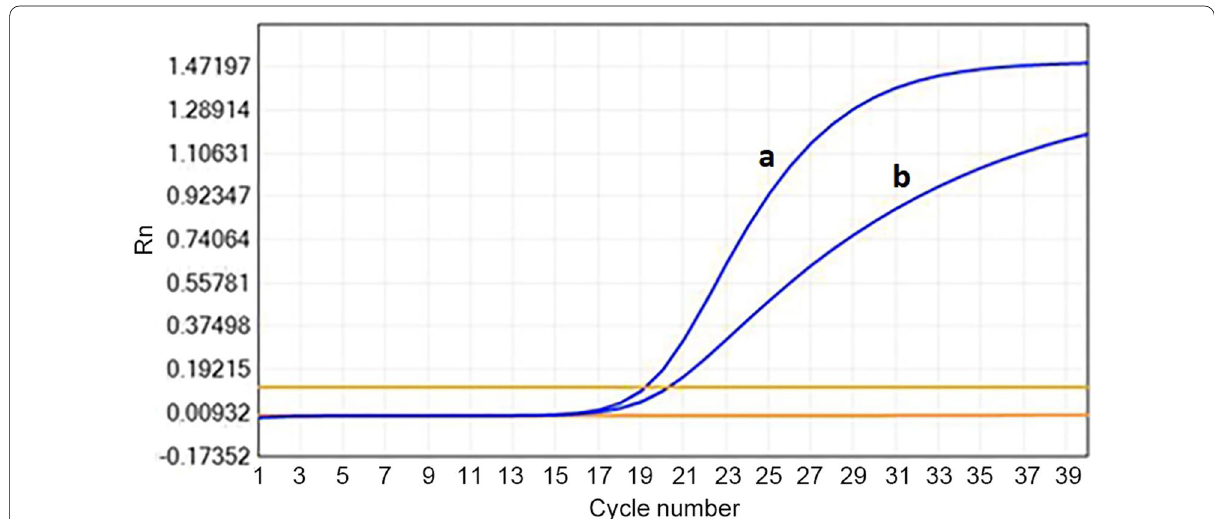
Fig. 1 Better PCR amplification effect was obtained after enzyme-lysed C.albicans sample treated with high temperature metal bath. The amplification curve produced by samples treated with high temperature metal bath (a), which displays a typical S-shape with significantly higher ΔRn and lower Ct values when comparing with the curve produced by the sample without metal bath treatment